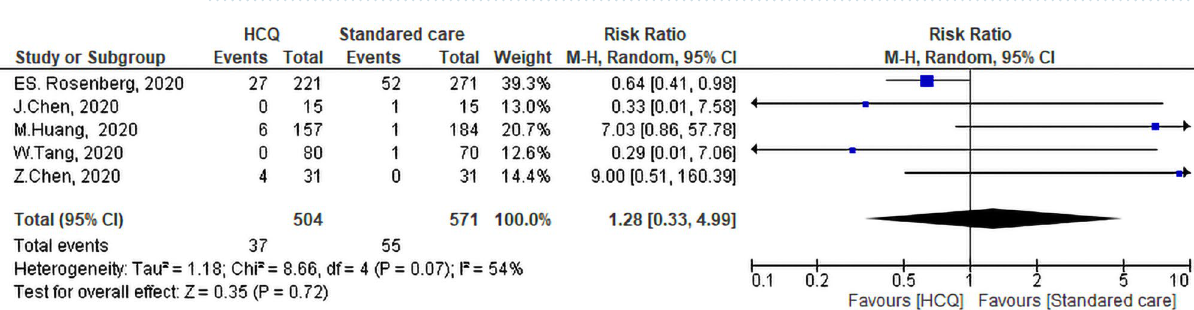
Figure 13. Clinical worsening of the Hydroxychloroquine versus the standard